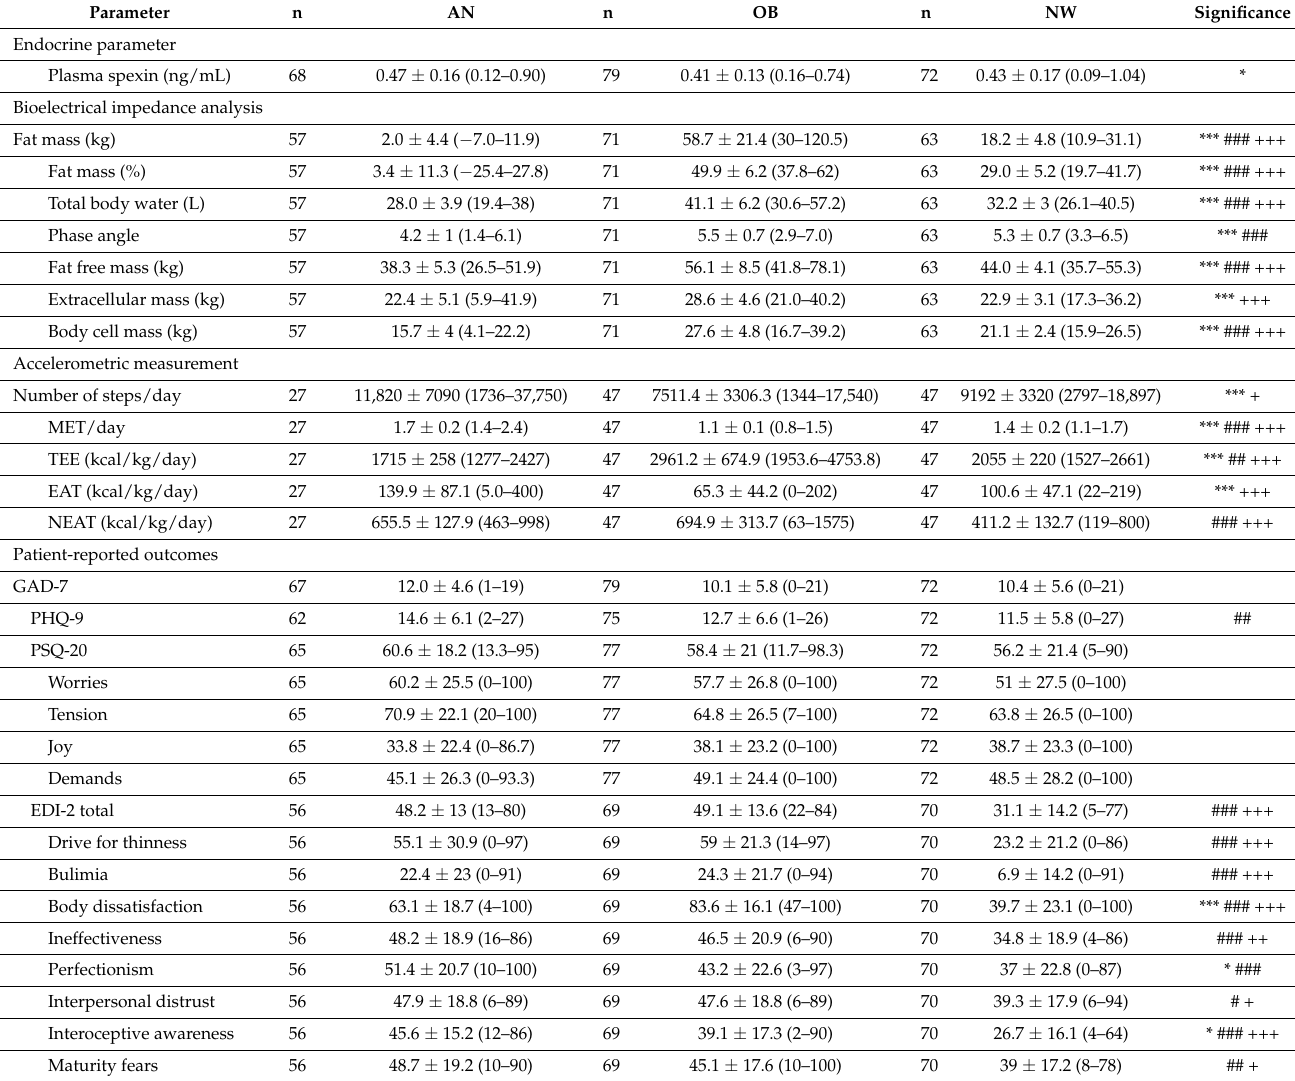
Table 2. Endocrine parameters, body composition, physical activity, energy expenditure, and patient- reported outcomes of the study